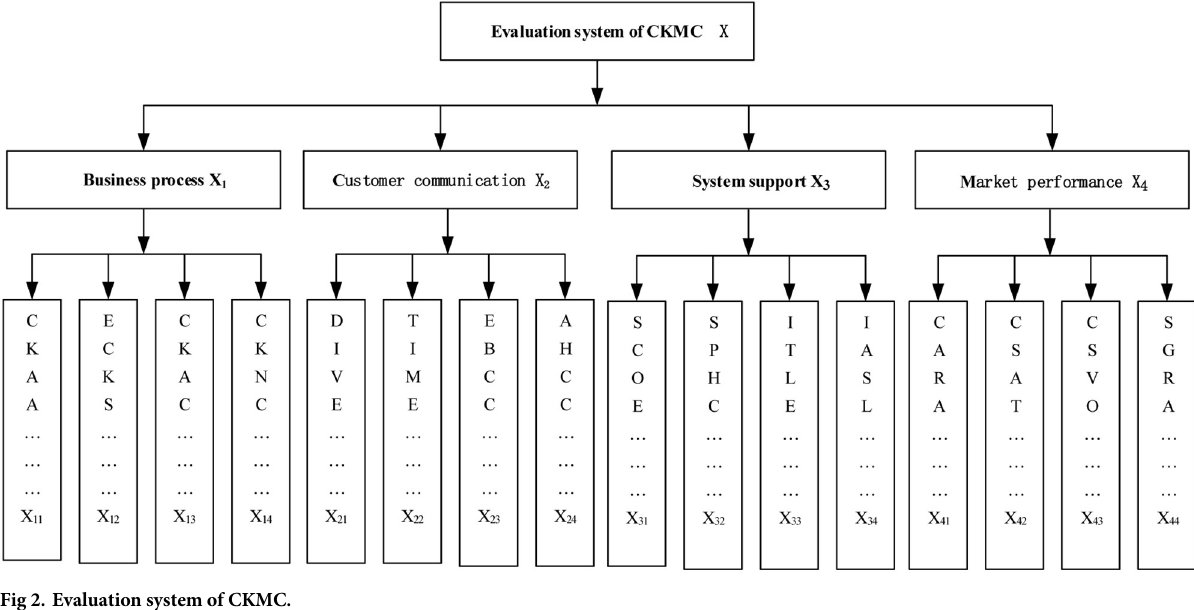
Fig 2. Evaluation system of CKMC.